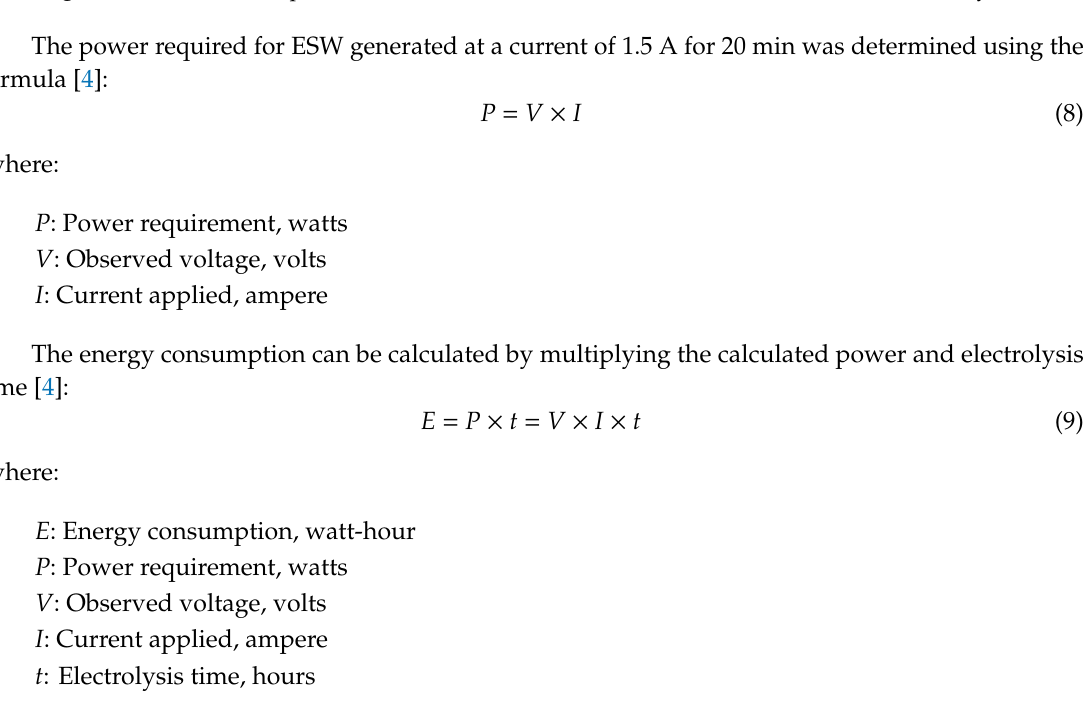
Figure 4. Behavior of ( a ) pH and ORP; and ( b ) FC concentrations at 1.5 A for 30 minutes of electrolysis